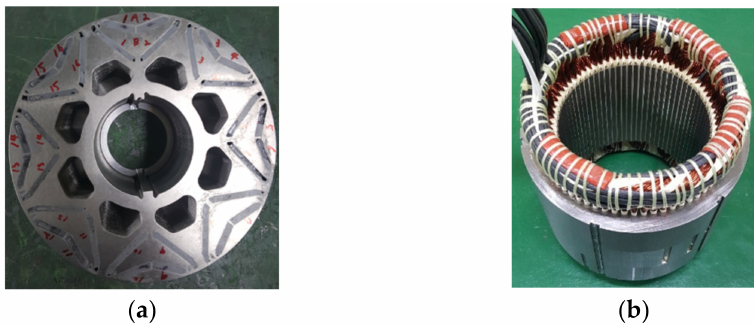
Figure 18. Topologies of the manufactured model: ( a ) rotor; ( b ) stator.